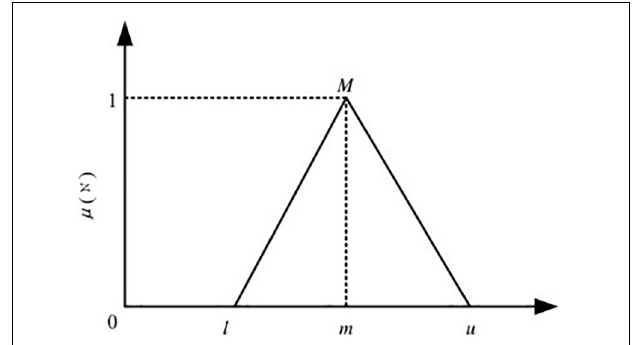
FIGURE 3 | Fuzzy Delphi triangle